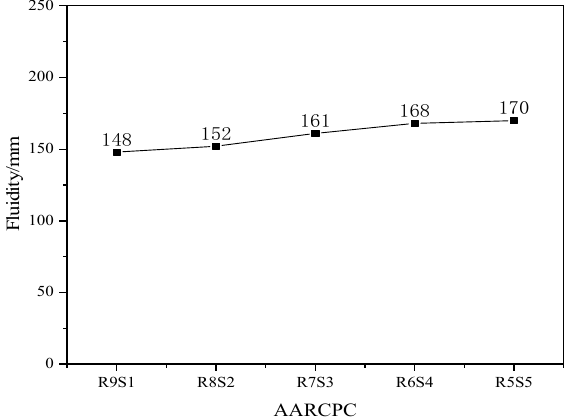
Figure 4. Fluidity of AARCPC with different slag content.